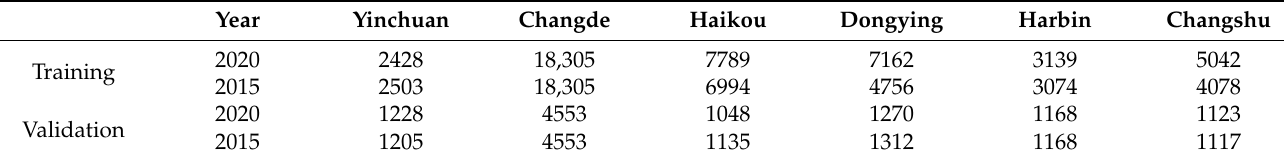
Table 4. Training and validation sample points in 6